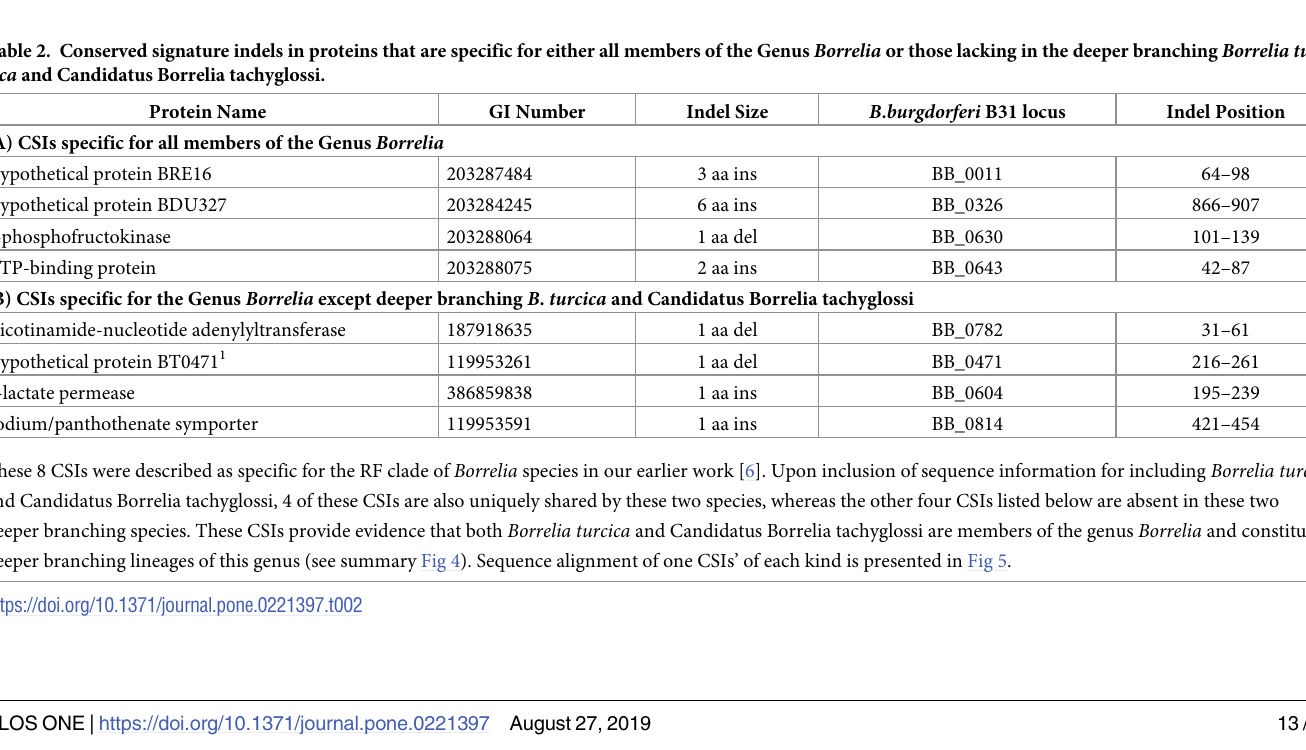
Fig 5. Partial sequence alignments of two CSIs in proteins with outgroup species that were previously reported as specific for the RF clade. Panel (A) shows a 6 aa insert in a hypothetical protein BDU327 (BB_0326) that is specifically found in all members of the genus Borrelia including B . turcica and Candidatus Borrelia tachyglossi. (B) This panel shows a 1 aa insert in the L-lactate permease protein, which is only shared by all RF clade species but is absent in the B . turcica and Candidatus Borrelia tachyglossi homologs, which are deeper branching members of the genus Borrelia (see Figs 3 and 4). Dashes (-) in all alignments shows sequence identity with the amino acids on the top line.